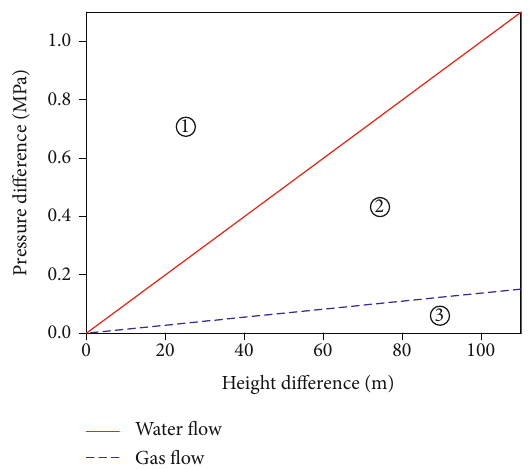
Figure 8: Relationship of pressure di ff erence and height di ff erence between the two coal seams.